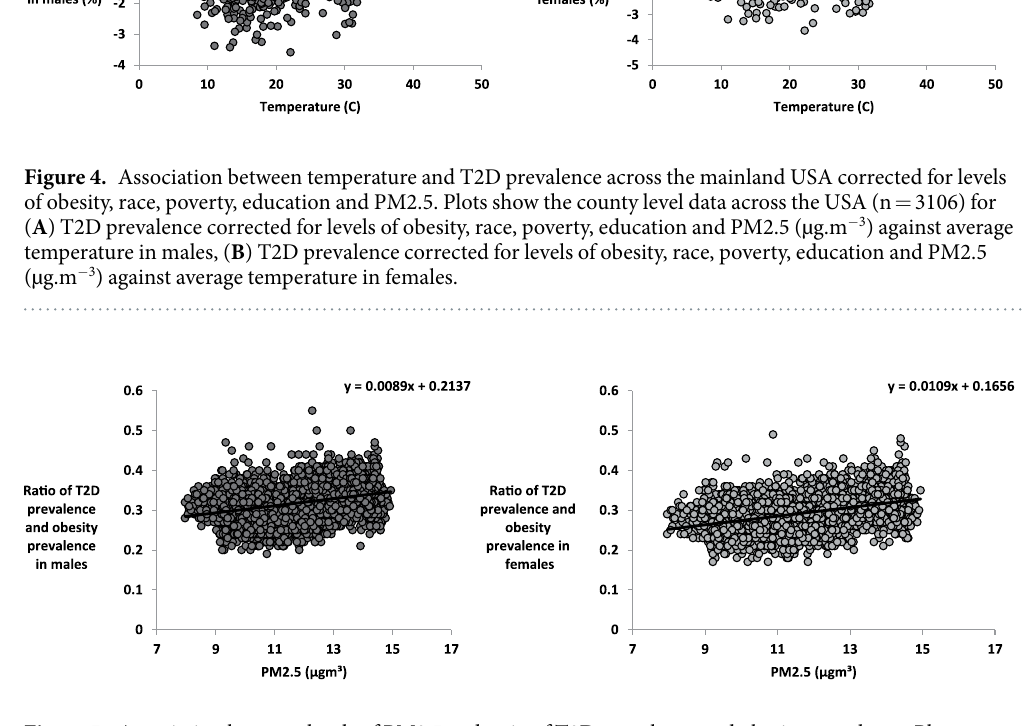
Figure 5. Association between levels of PM2.5 and ratio of T2D prevalence and obesity prevalence. Plots show the county level data across the USA (n = 3106), and global for ( A ) ratio of T2D prevalence and obesity prevalence against average PM2.5 ( µ g.m − 3 ) for males, ( B ) ratio of T2D prevalence and obesity prevalence (T2D/ Ob) against average PM2.5 ( µ g.m − 3 ) for females.